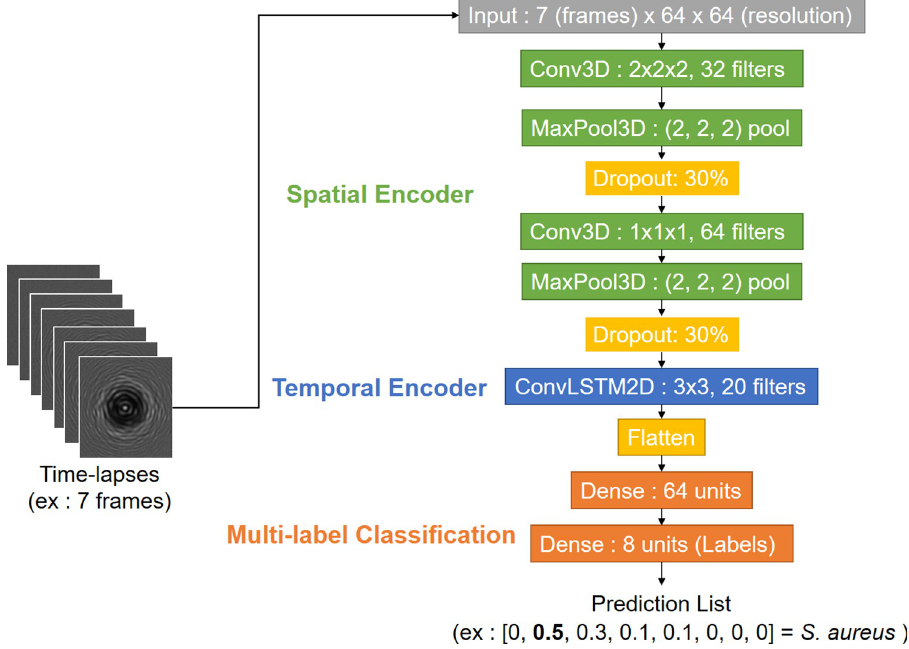
Fig 4. Architecture of a seven-frame classification network based on a Conv3D+LSTM2D principle. The network is composed of three parts: a spatial encoding phase with convolutional layers, a temporal encoding phase with a recurrent layer and dense layers to classify the